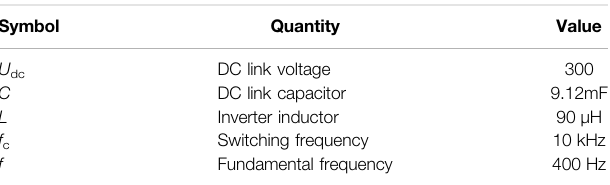
TABLE 1 | Simulation and Experiments